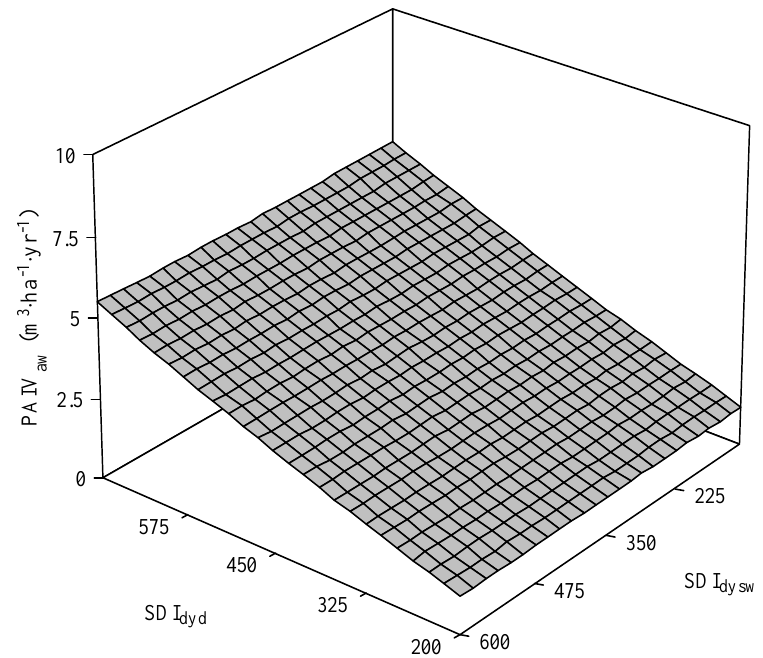
Figure 2. Trembling aspen volume PAIV as a function of deciduous (SDI dyd ) and spruce dynamic SDI (SDI dysw ) (HT sw and HT aw held constant). Model: PAIV aw = 0.0002 × SDI dyd1.24 × SDI dysw0.03 × HT sw0.17 × HT aw0.65 .